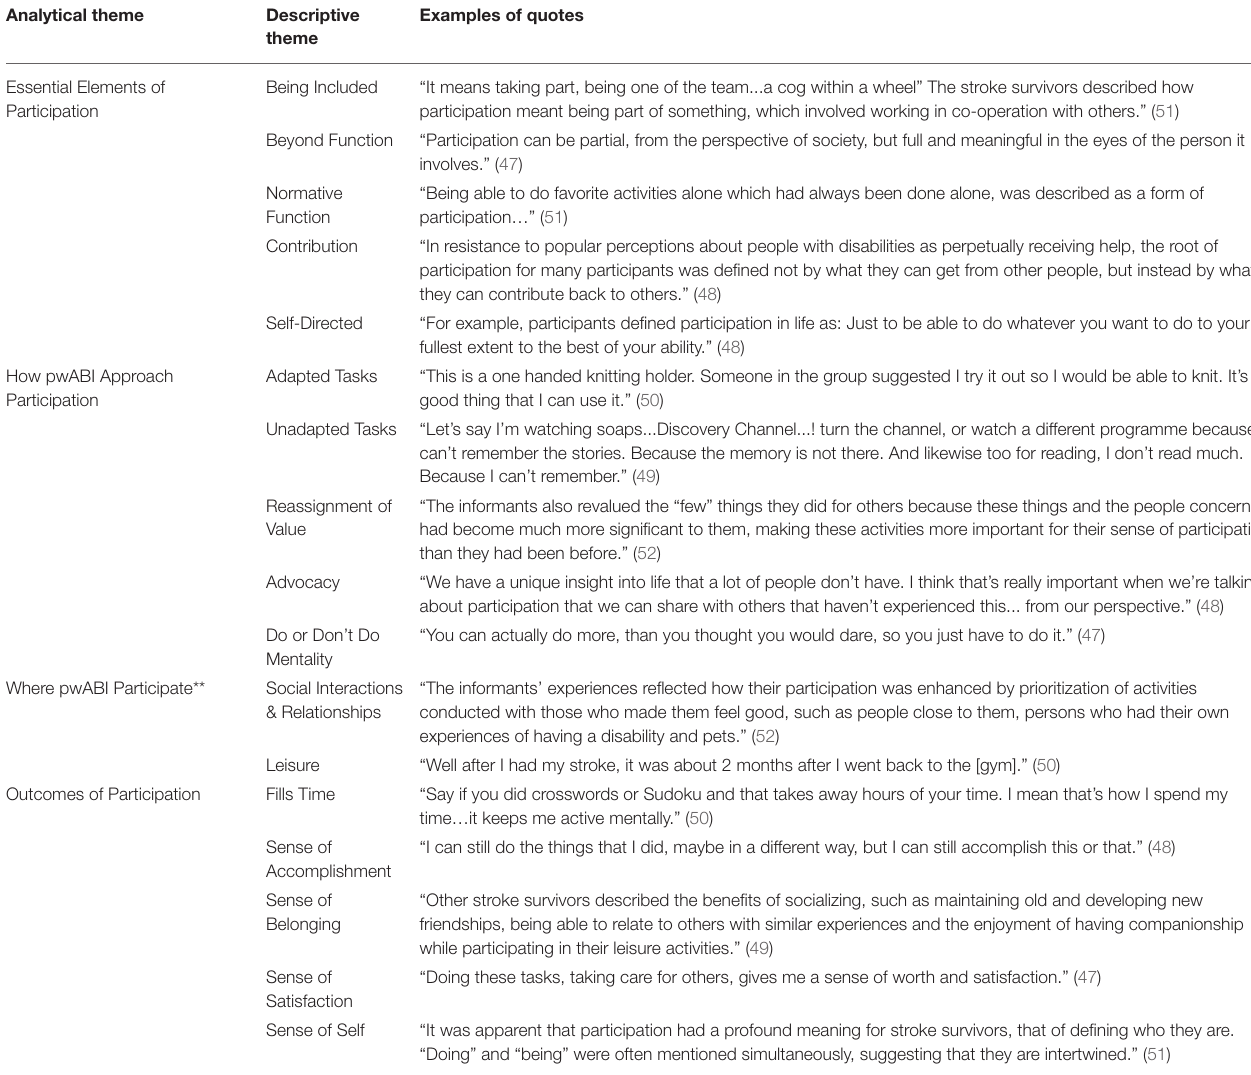
TABLE 4 | Examples of article quotes that support each